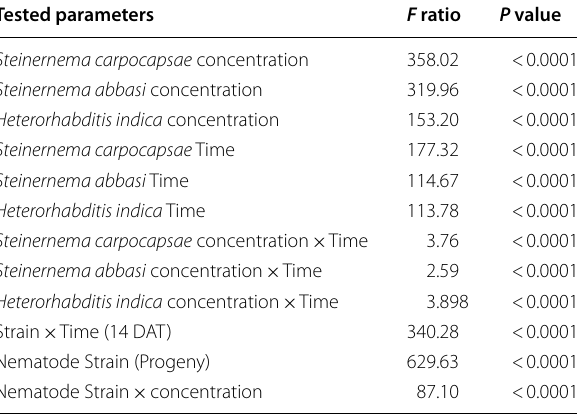
Table 1 Statistics from the ANOVA used to analyse (A) the number of individuals died after different days of exposure to different EPN strain along with control under direct toxicity Tested parameters F